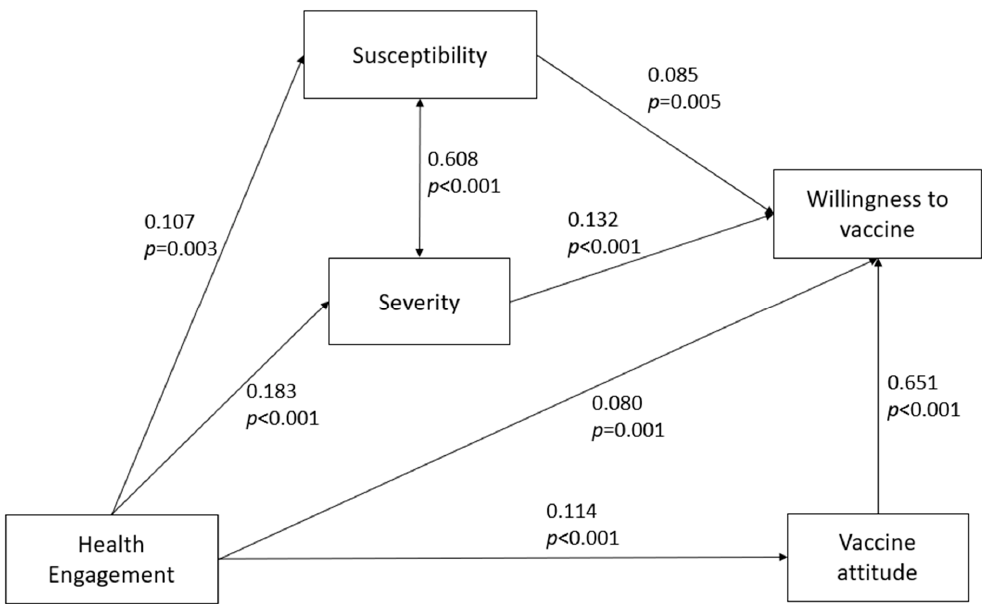
Figure 1. Tested path model. Numbers on arrows represent standardized regression weights and relative p -values.